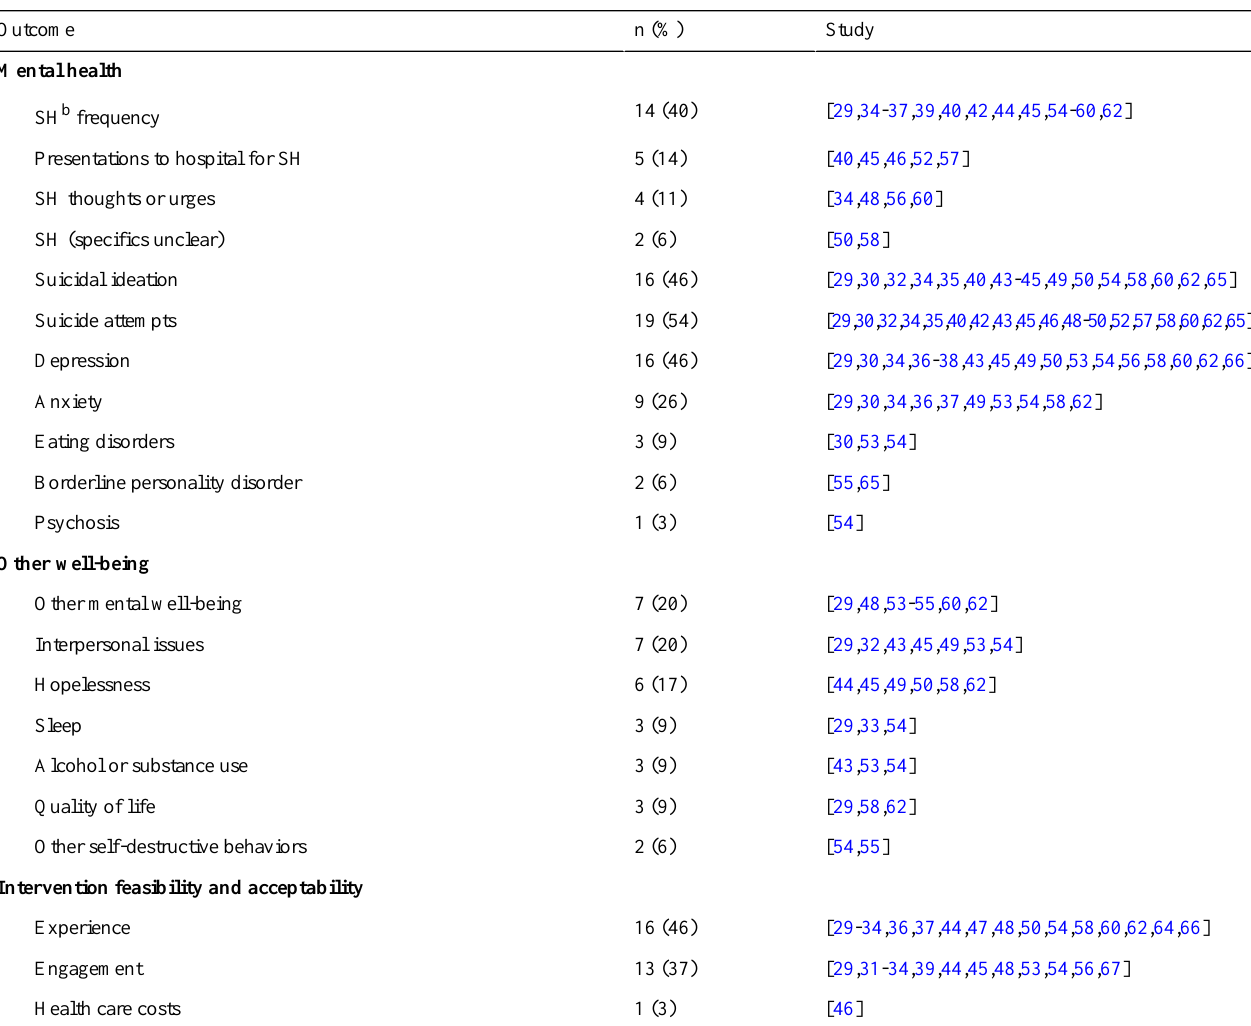
Table 4. Study outcomes (n=35). a